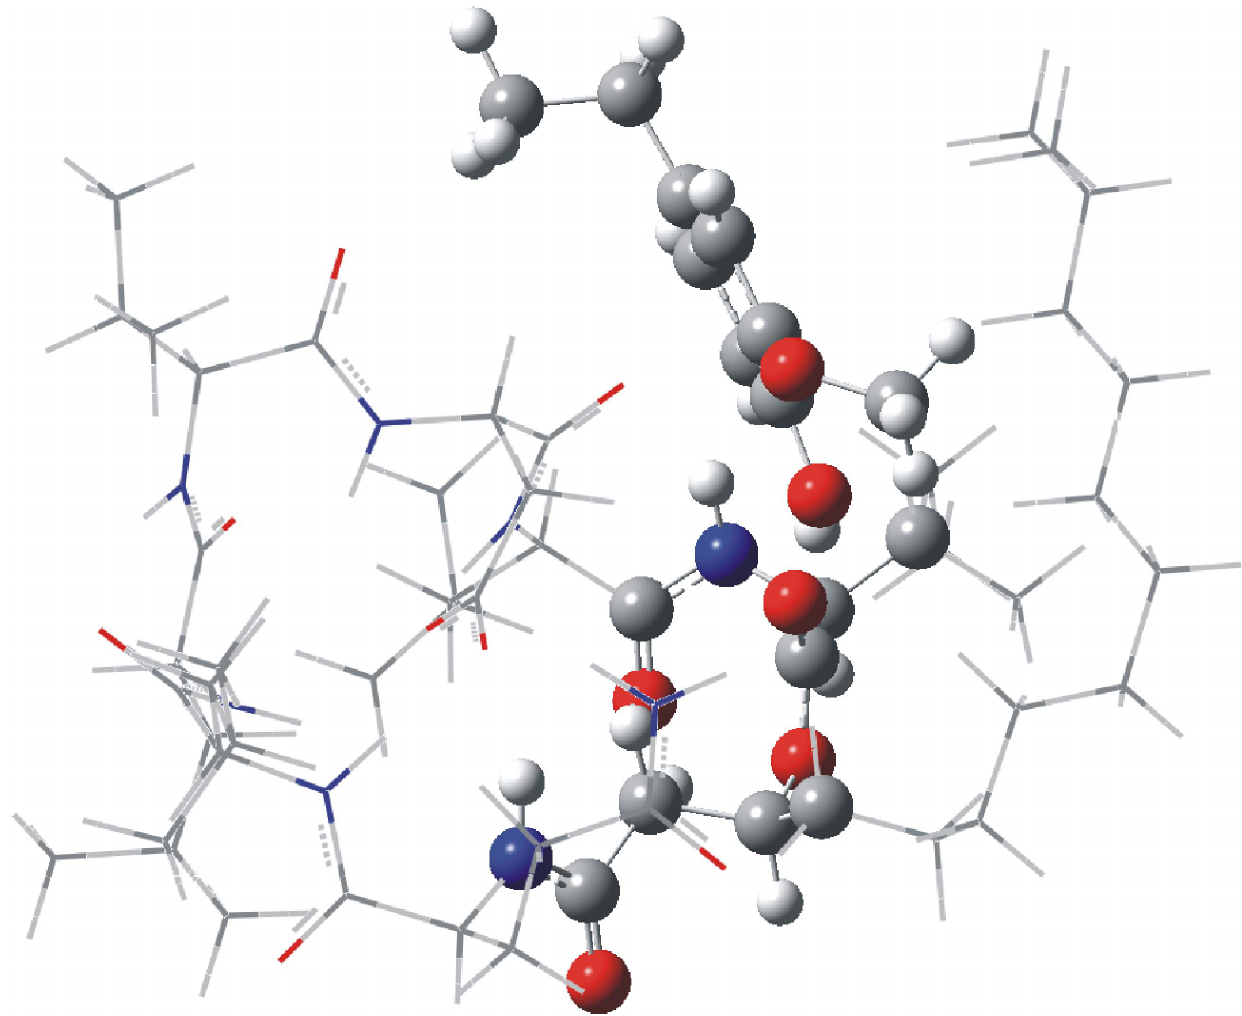
Figure 9. The mixed level of theory in which the nucleus calculated at B3LYP/6 2 31 + G(d) is shown as ball & bond type and periphery region calculated at PM6 is shown as